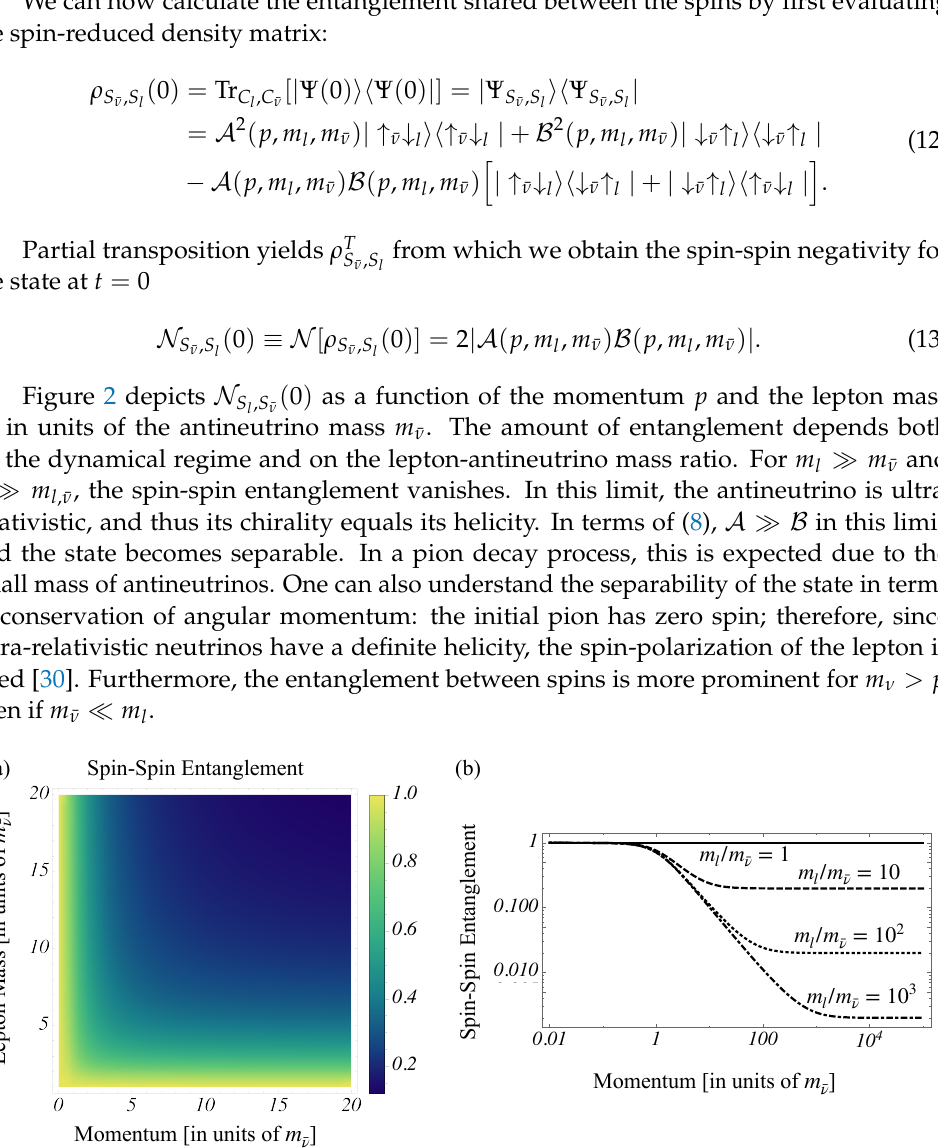
Figure 2. ( a ) Entanglement between the lepton and the antineutrino spins in the initial state (8) as a function of the momentum and of the lepton mass (in units of the antineutrino mass). ( b ) Same as ( a ) but for specific lepton-antineutrino mass ratios as a function of the momentum (in log-log